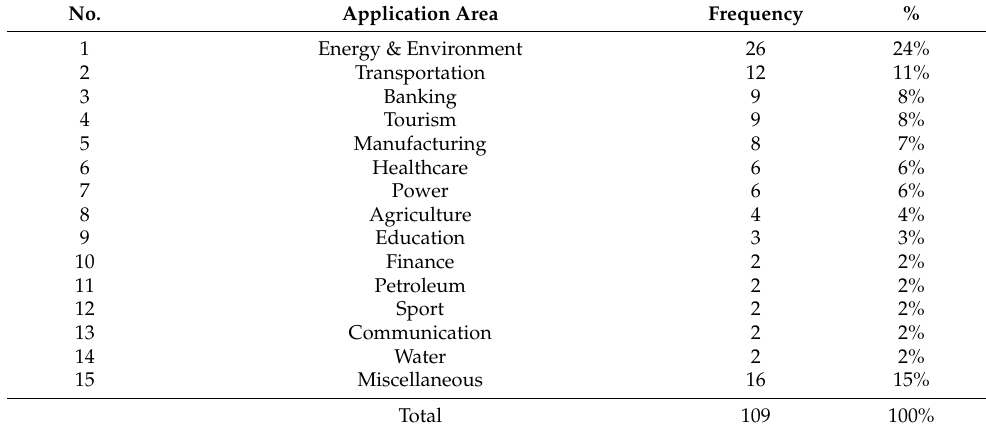
Table 2. Number and percentage of articles in each application area.